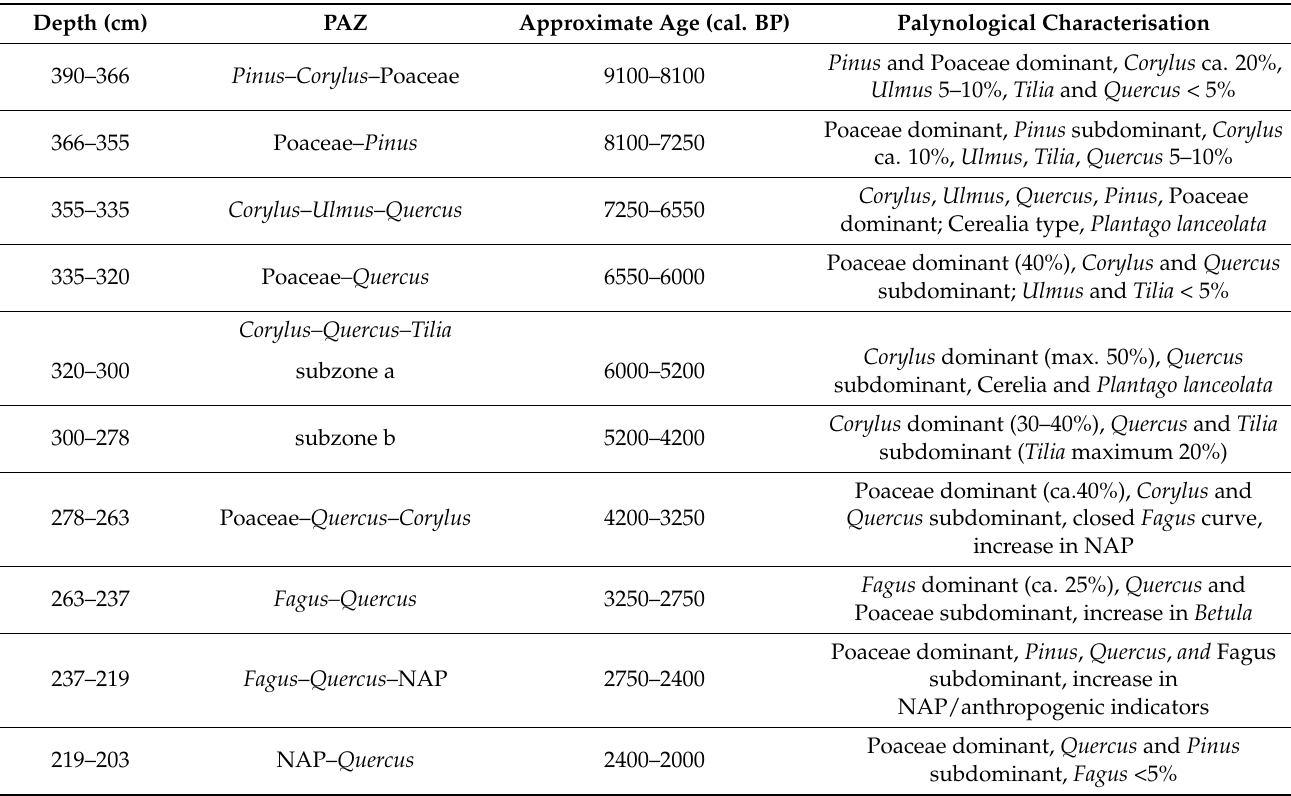
Table 2. Pollen assemblage zones (PAZ) of profile Moenchborn.